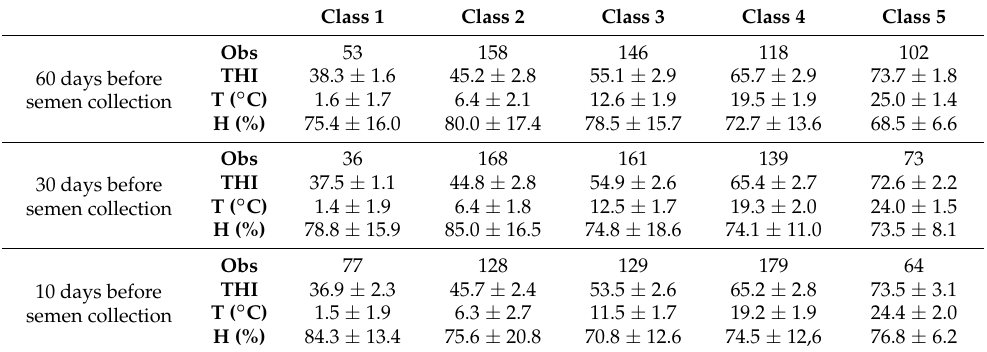
Table 4. Characteristics of the classes (Mean ± SD) among the three different considered periods.